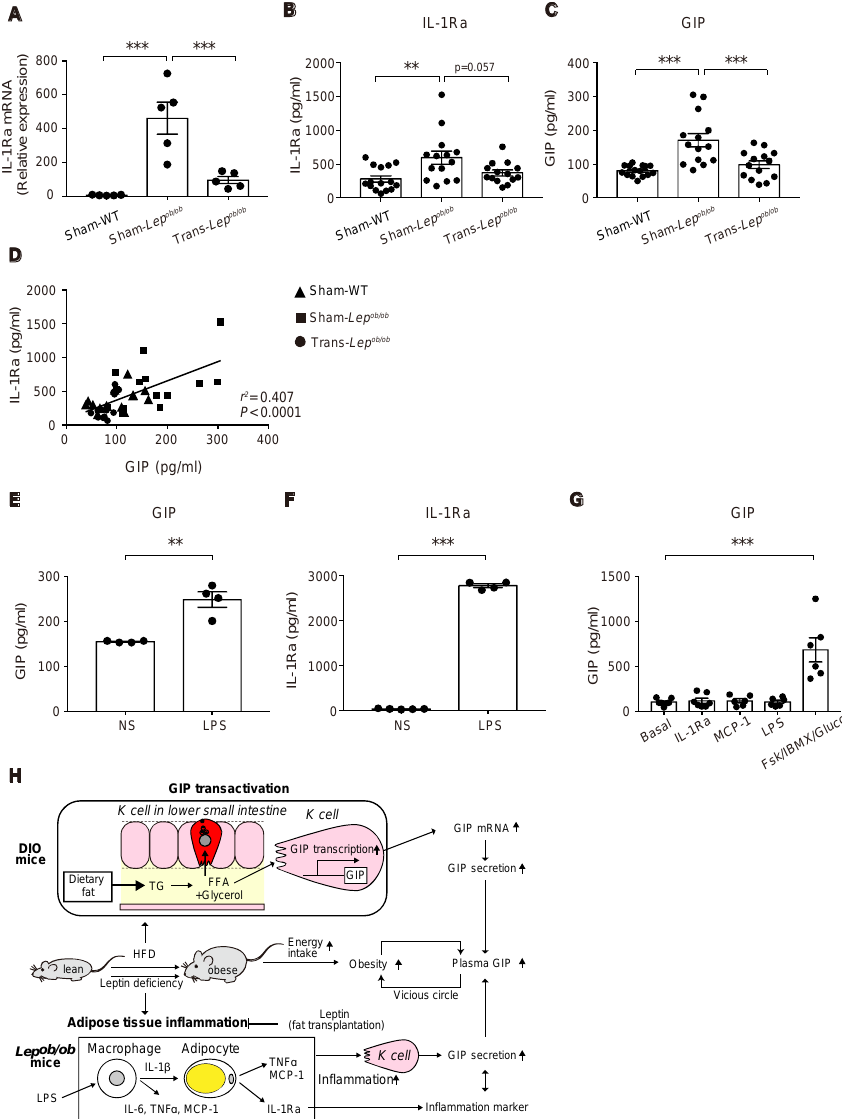
Figure 8. Effect of fat transplantation and LPS administration on GIP and IL-1Ra and a model for the mechanism of hypersecretion of GIP in obesity. ( A – C ) IL-1Ra mRNA expression in epididymal fat and plasma levels of IL-1Ra ( B ) and GIP ( C ) in Trans- Lep ob / ob , Sham- Lep ob / ob , and Sham-WT. ( D ) Scatterplots of plasma levels of IL-1Ra and GIP of Trans- Lep ob / ob (circles), Sham- Lep ob / ob (squares), and Sham-WT (triangles). The dotted line depicts the regression line for all data ( r 2 = 0.407, p < 0.0001). ( E , F ) Plasma levels of GIP ( E ) and IL-1Ra ( F ) at 3 h after LPS administration to WT mice. ( G ) GIP secretion from mouse small intestinal organoids after 2 hr stimulation with MCP-1, IL-1Ra, LPS or forskolin / IBMX / 10 mM glucose (FSK / IBMX / Glucose). ( A – C , E – G ) Data are expressed as mean ± SEM. ** p < 0.01, *** p < 0.001. ( H ) A model of hypersecretion of GIP in obesity. See the text in